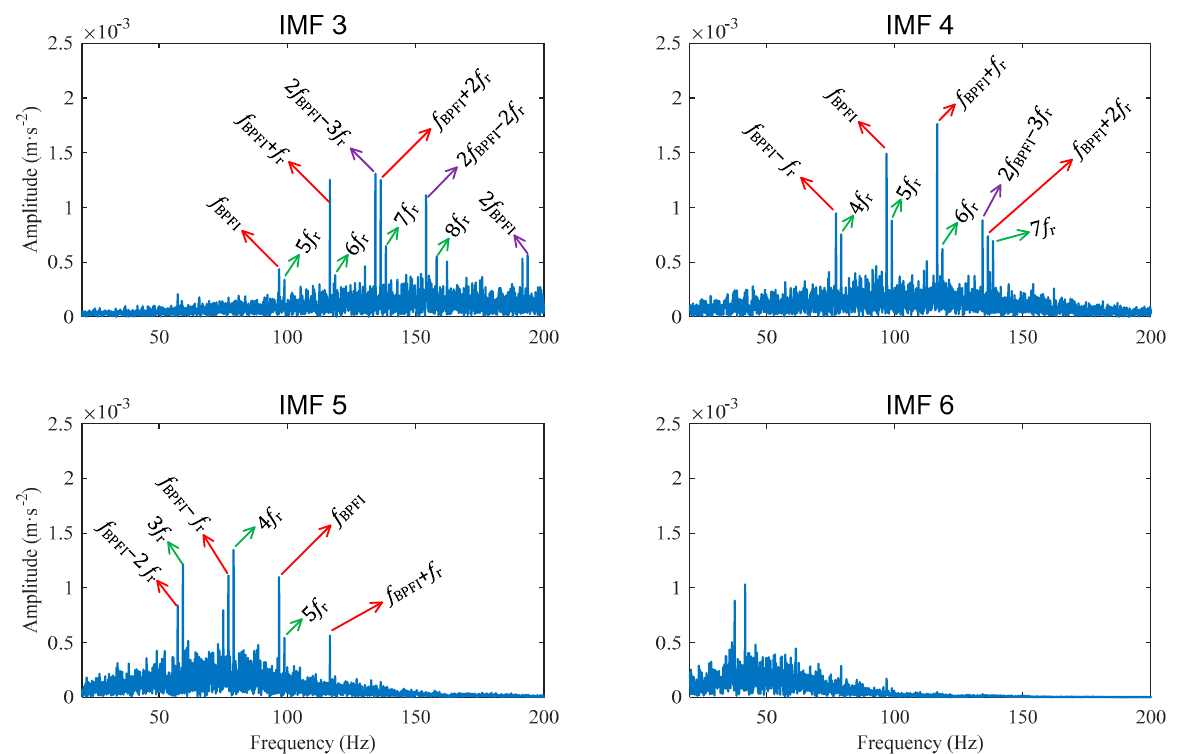
Figure 12. Case 2 for inner race defect: Amplitude spectra of IMFs obtained from the compressed signal.